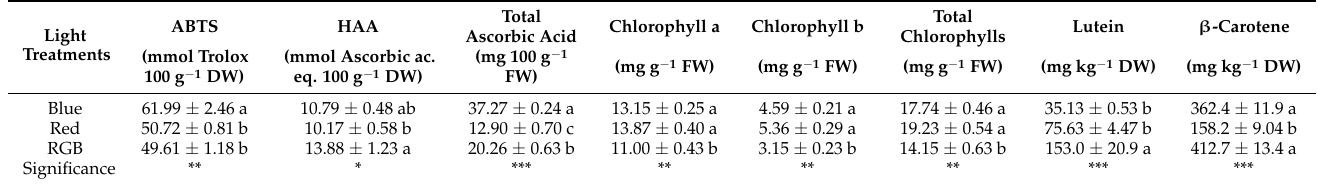
Table 4. Antioxidant activities, total ascorbic acid and photosynthetic pigments of parsley microgreens with reference to the different light treatments (red, blue and